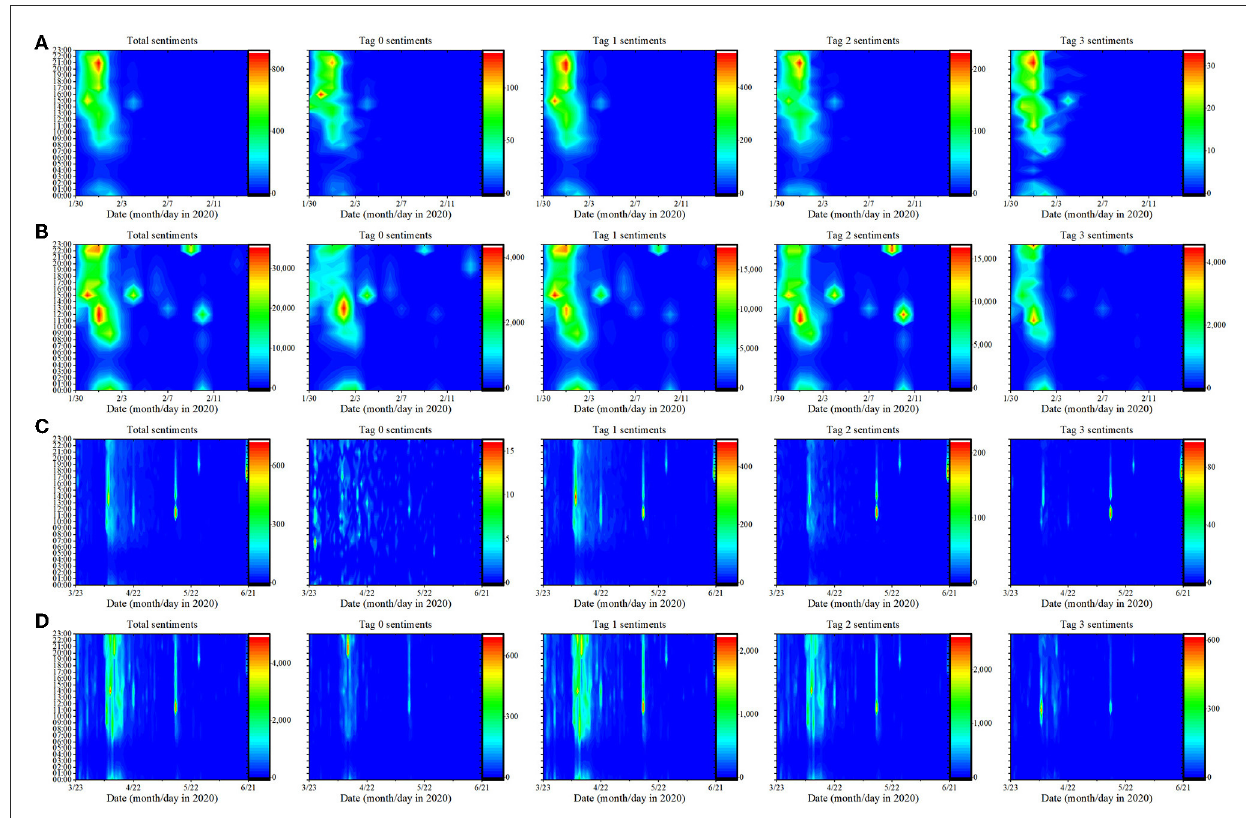
FIGURE4 The time series of different public sentiments in 24h of “The Wuhan Red Cross” and “Fangfang Diary”. (A) Posts sentiments of “The Wuhan Red Cross”. (B) Audience sentiments of “The Wuhan Red Cross”. (C) Posts sentiments of “Fangfang Diary”. (D) Audience sentiments of “Fangfang